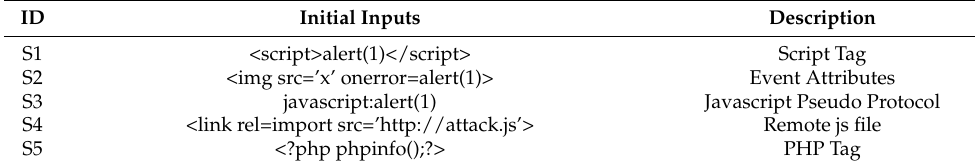
Table 2. Initial inputs.